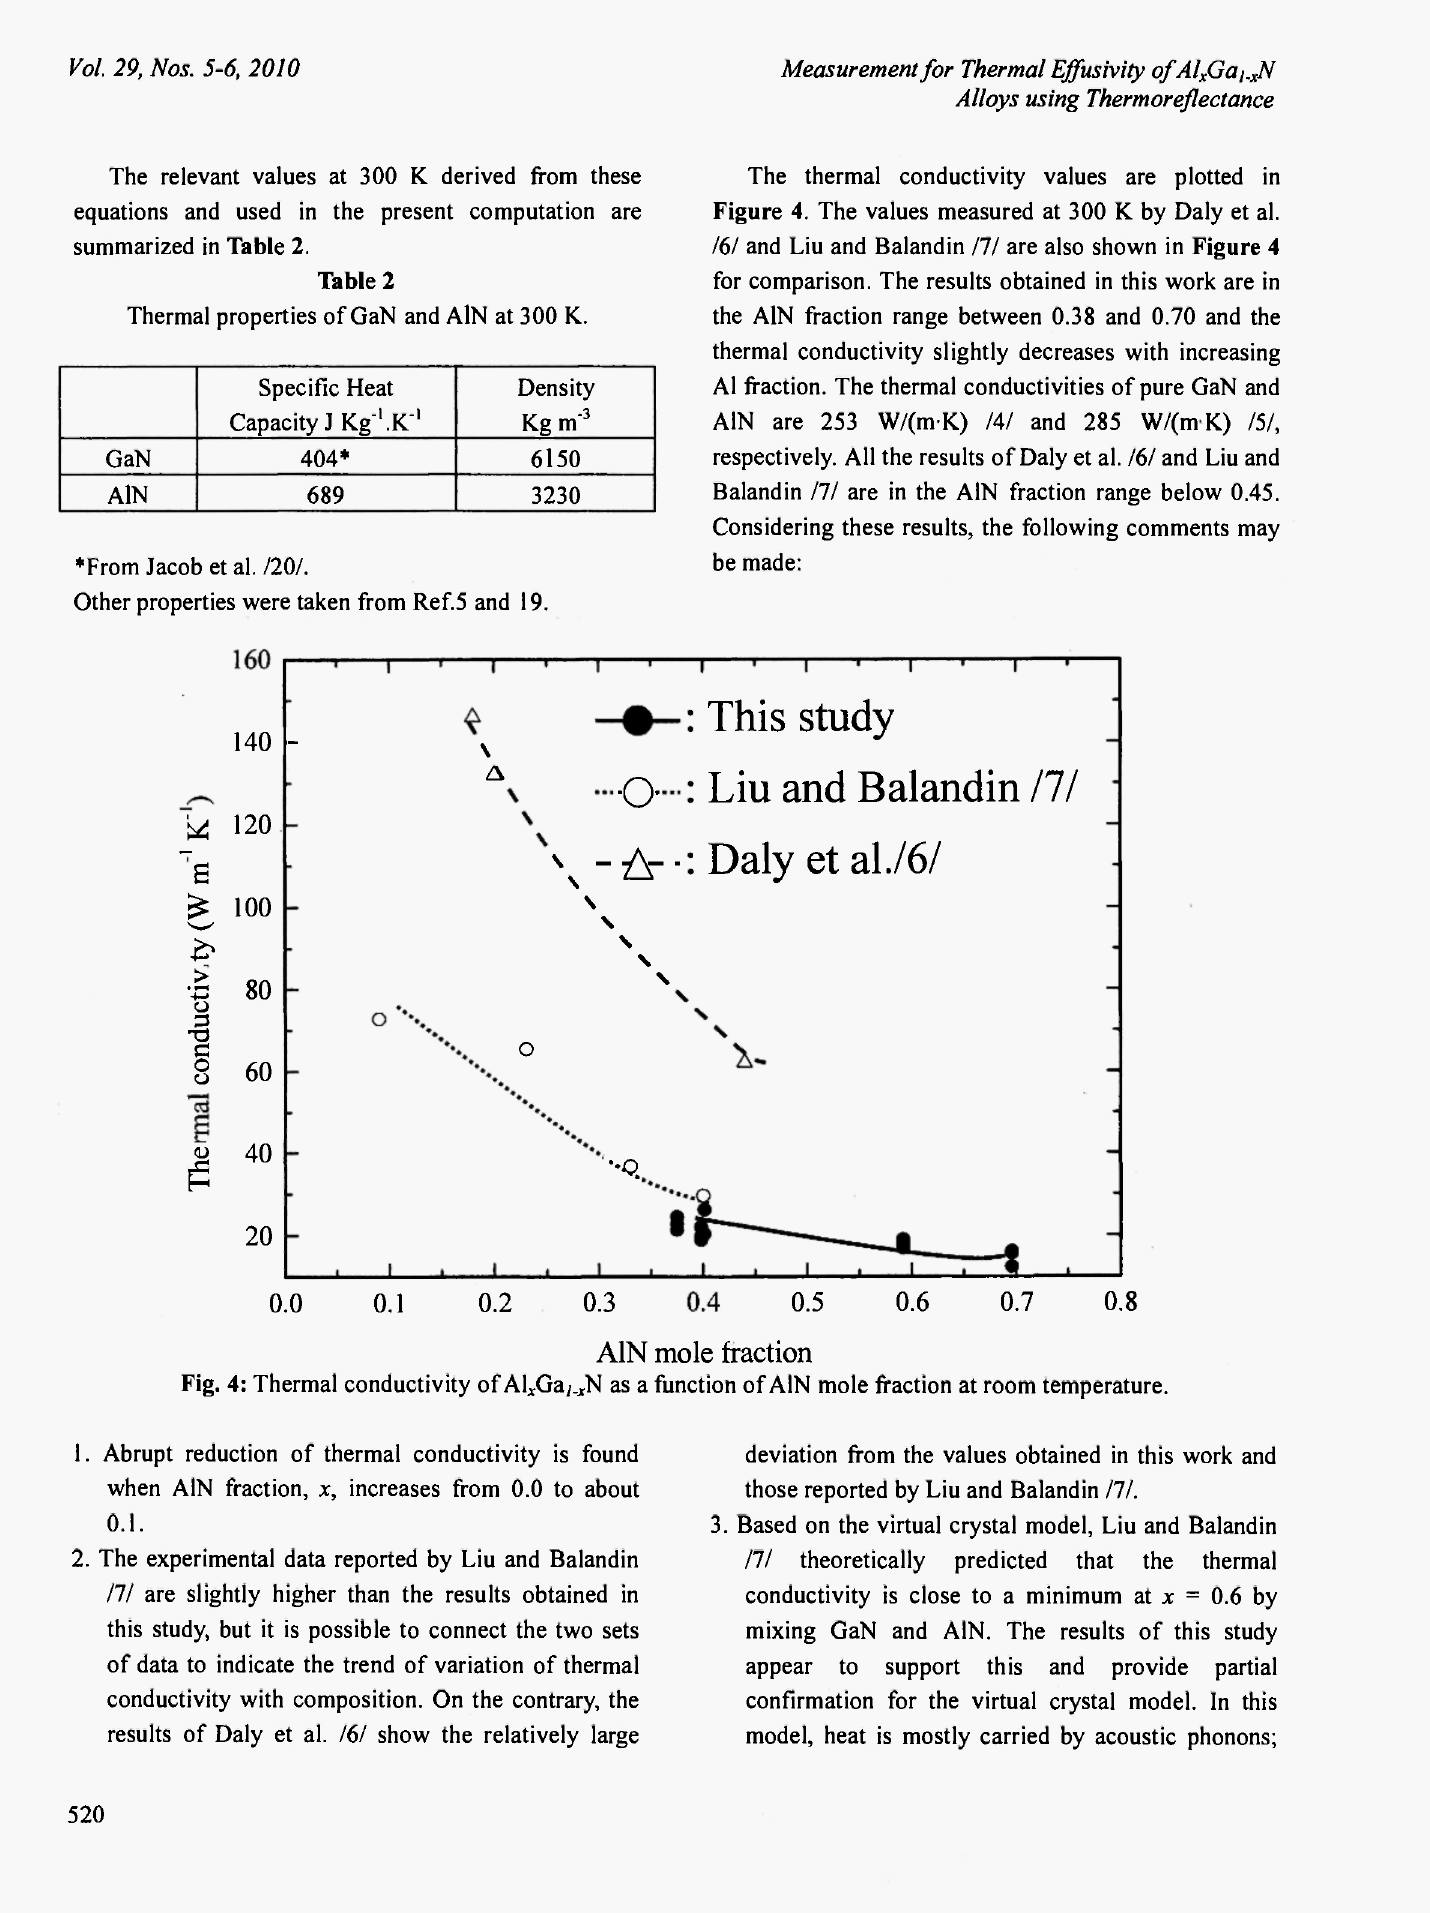
Figure 4. The values measured at 300 Κ by Daly et al. /6/ and Liu and Balandin 111 are also shown in Figure 4 for comparison. The results obtained in this work are in the A1N fraction range between 0.38 and 0.70 and the Al fraction. The thermal conductivities of pure GaN and A1N are 253 W/(m K) /4/ and 285 W/(mK) 151,